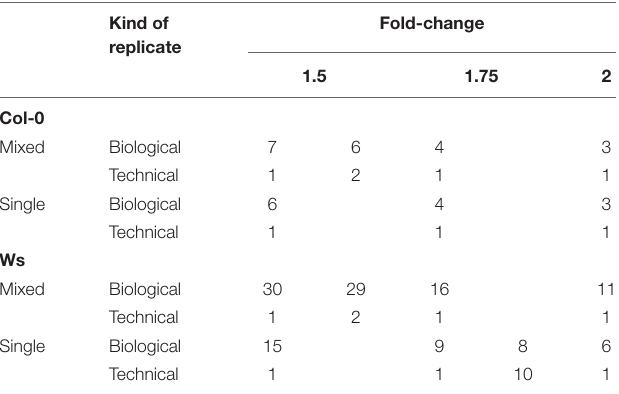
TABLE 1 | Required numbers of replicates for proteomic study of A. thaliana Col-0 and Ws ecotypes grown from seeds collected from a single parent plant (Single) and a set of parent plants